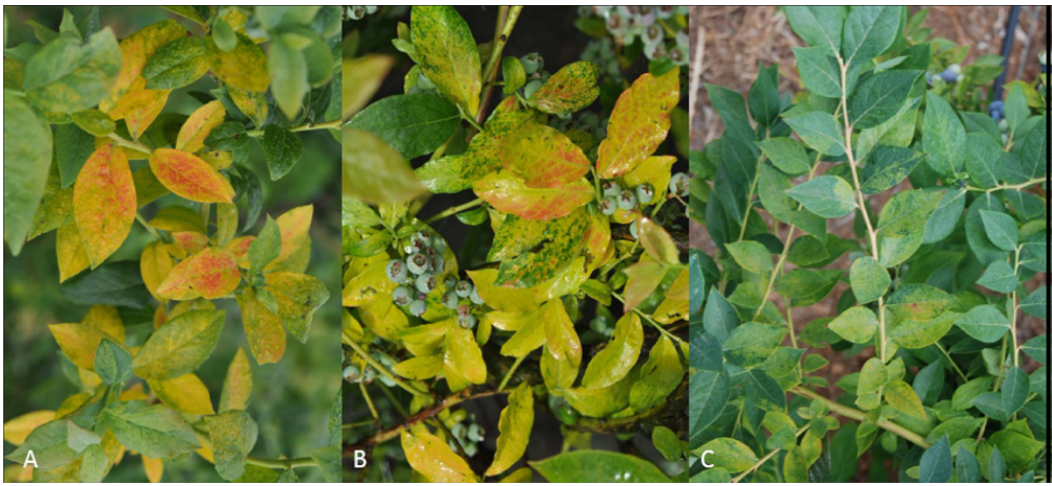
Figure 6. Blueberry mosaic symptoms in cultivars chlorosis, reddening and mosaic symptoms observed in many cultivars: ( A ) ‘Bluecrop’; ( B ) ‘Blueray’; and ( C )